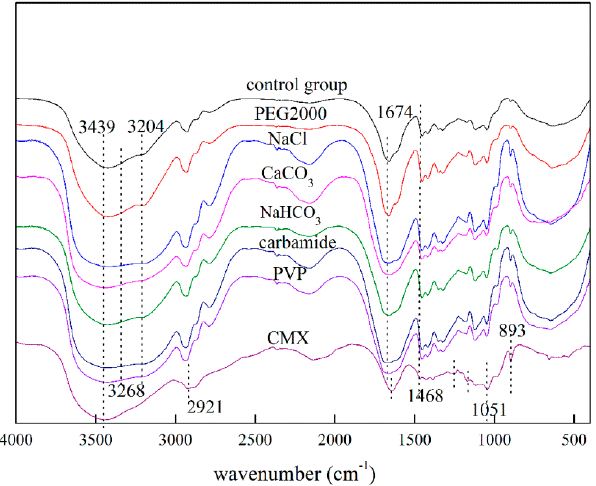
Figure 1. FTIR spectra of CMX and prepared hydrogels with or without six kinds of pore-forming agents.